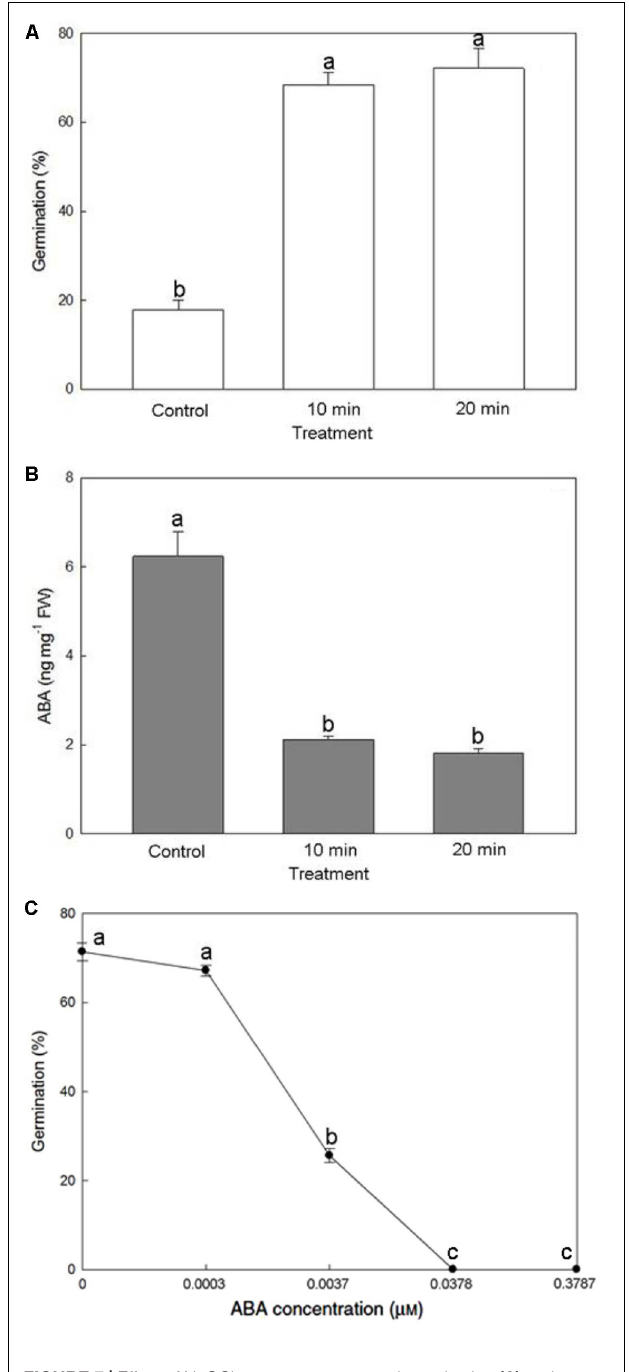
FIGURE 7 | Effect of NaOCl pretreatment on seed germination (A) and endogenous ABA content within the mature seeds (B) , and effect of exogenous ABA application on seed germination after the NaOCl pretreatment (C) . Bars labeled with the same letter are not significantly different at P ≤ 0.05 by Fischer’s protected LSD